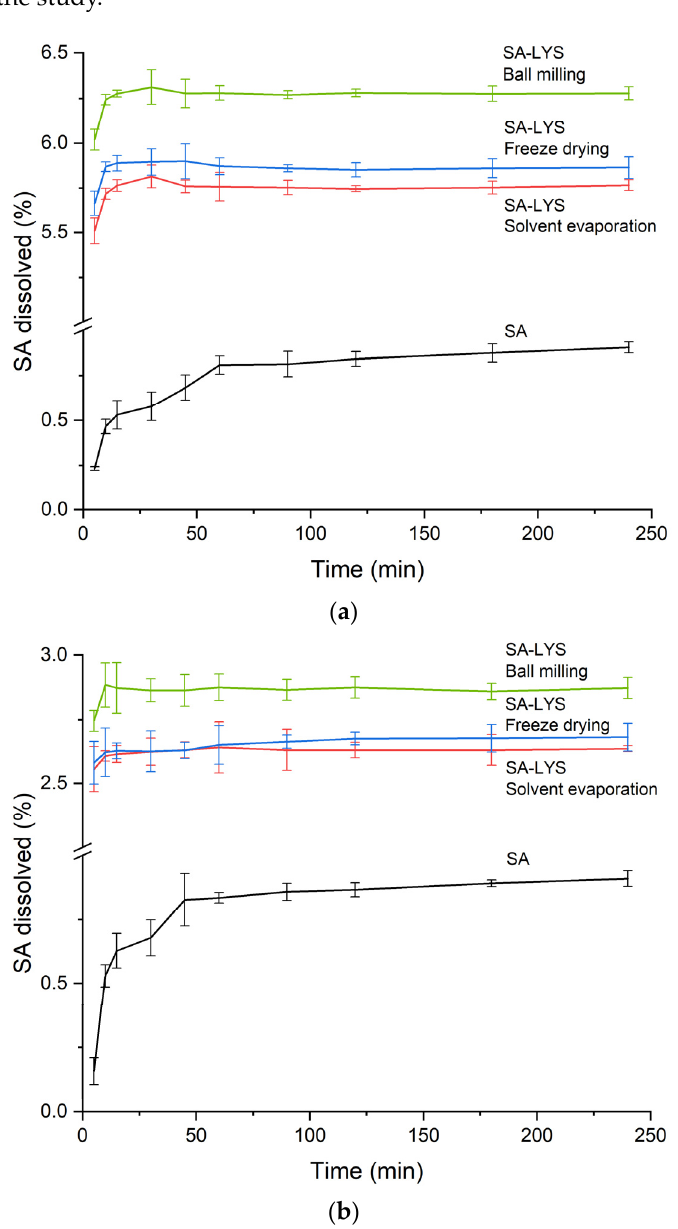
Figure 3. Dissolution profiles of SA and SA co-amorphous systems with LYS in molar ratio 1:1 in water ( a ) and HCl 0.1 N ( b ).